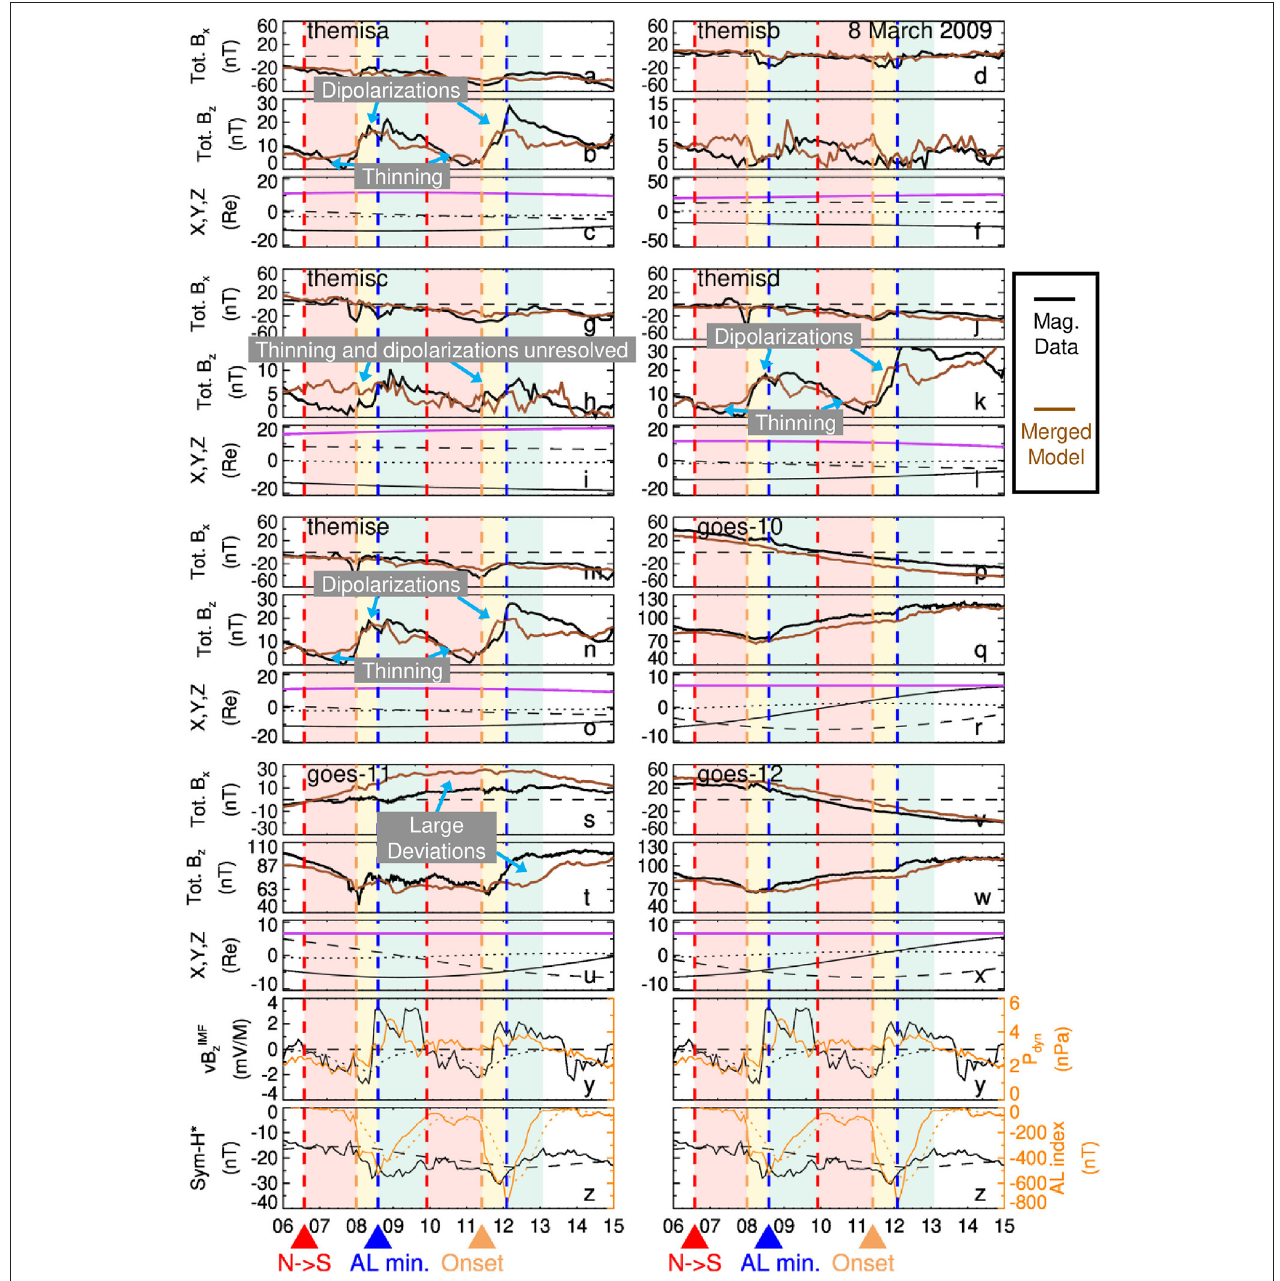
FIGURE 11 | In-situ validation of the Merged Model . The comparison between the THEMIS and GOES magnetometer data and the Merged Model reconstruction of the 8 March 2009 substorms. (a,b) The x and z components of the total magnetic field B tot observed by the THEMIS-A magnetometer (black line) averaged to 5 min resolution compared to the Merged Model evaluated at the spacecraft location (brown line) in the GSM coordinate system. (c) The THEMIS-A ephemeris in GSM coordinates with the x , y , z , and r components in solid, dashed, dotted, and purple lines, respectively. (d–x) The same as (a–c) except now for the other four THEMIS and three GOES satellites. (y,z) Geomagnetic indices and solar wind parameters in format similar to previous figures.